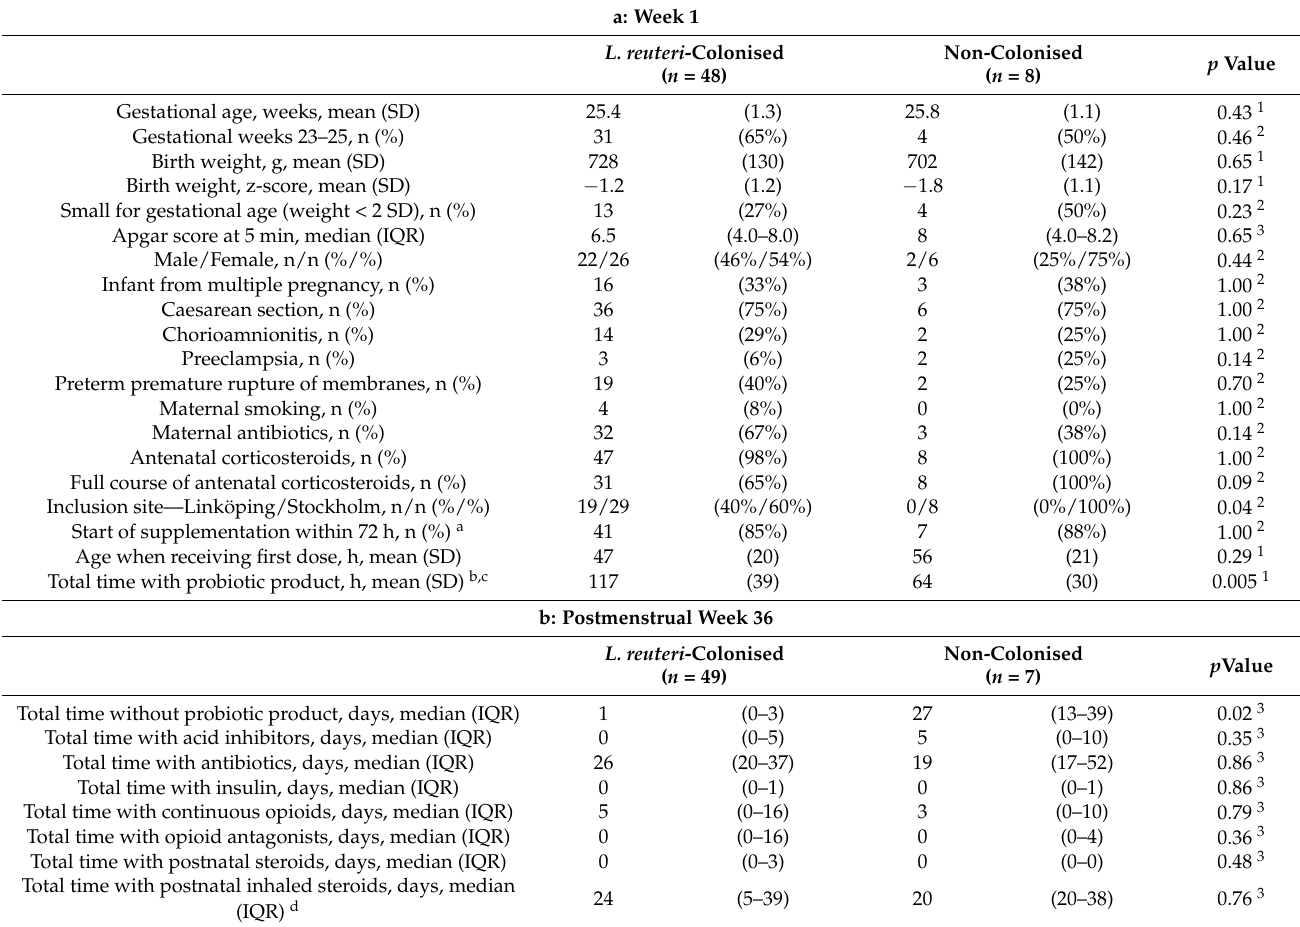
Table 1. Maternal and infant characteristics and L. reuteri prevalence in faeces of the L. reuteri -supplemented group. L. reuteri -supplemented infants were separated into colonised and non-colonised infants depending on whether their faeces were positive or negative for probiotic L. reuteri at one week of age ( a ) or at postmenstrual week 36 ( b ),